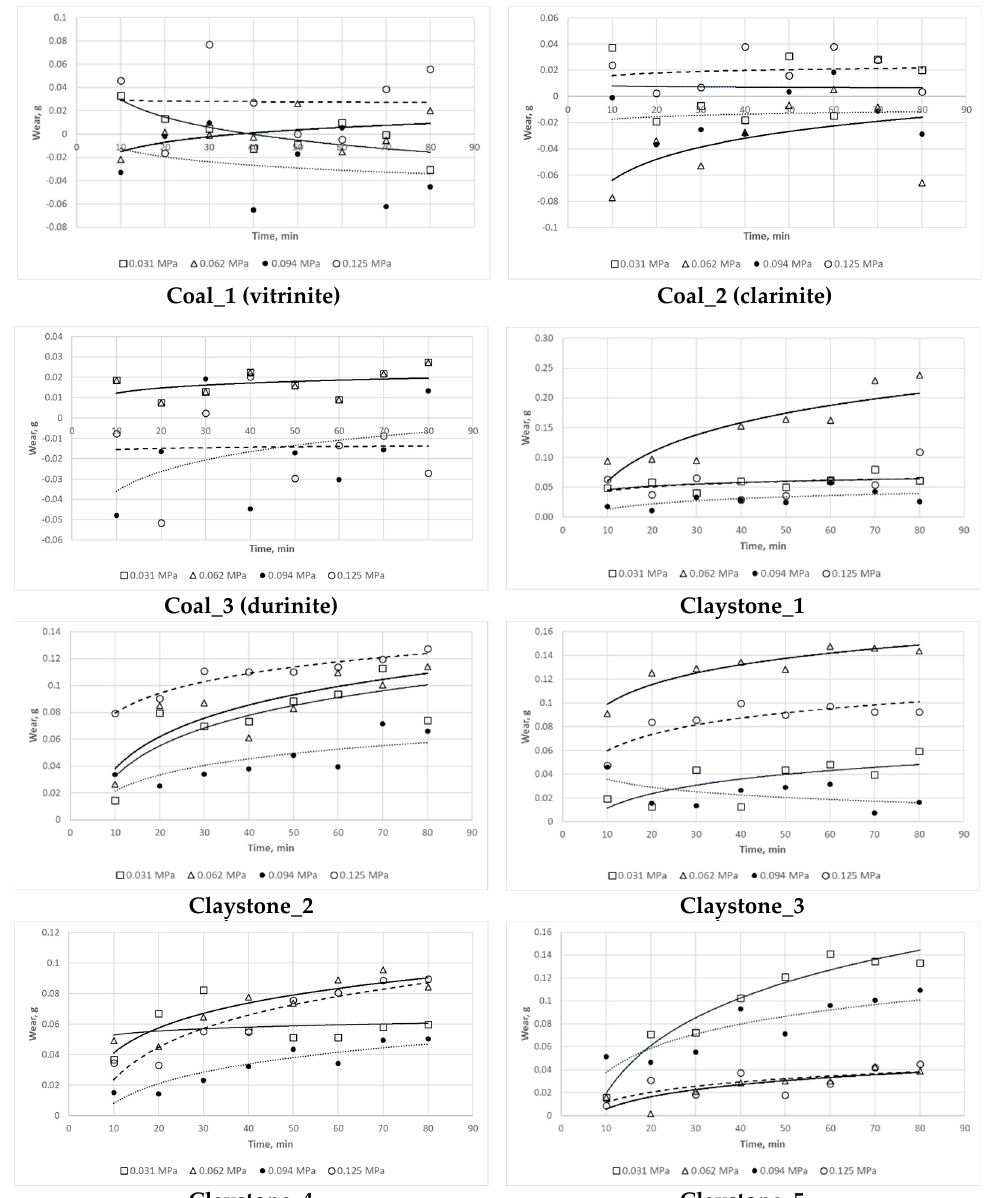
Figure 7. Wear test results for the coal and claystone abrasives under consideration.